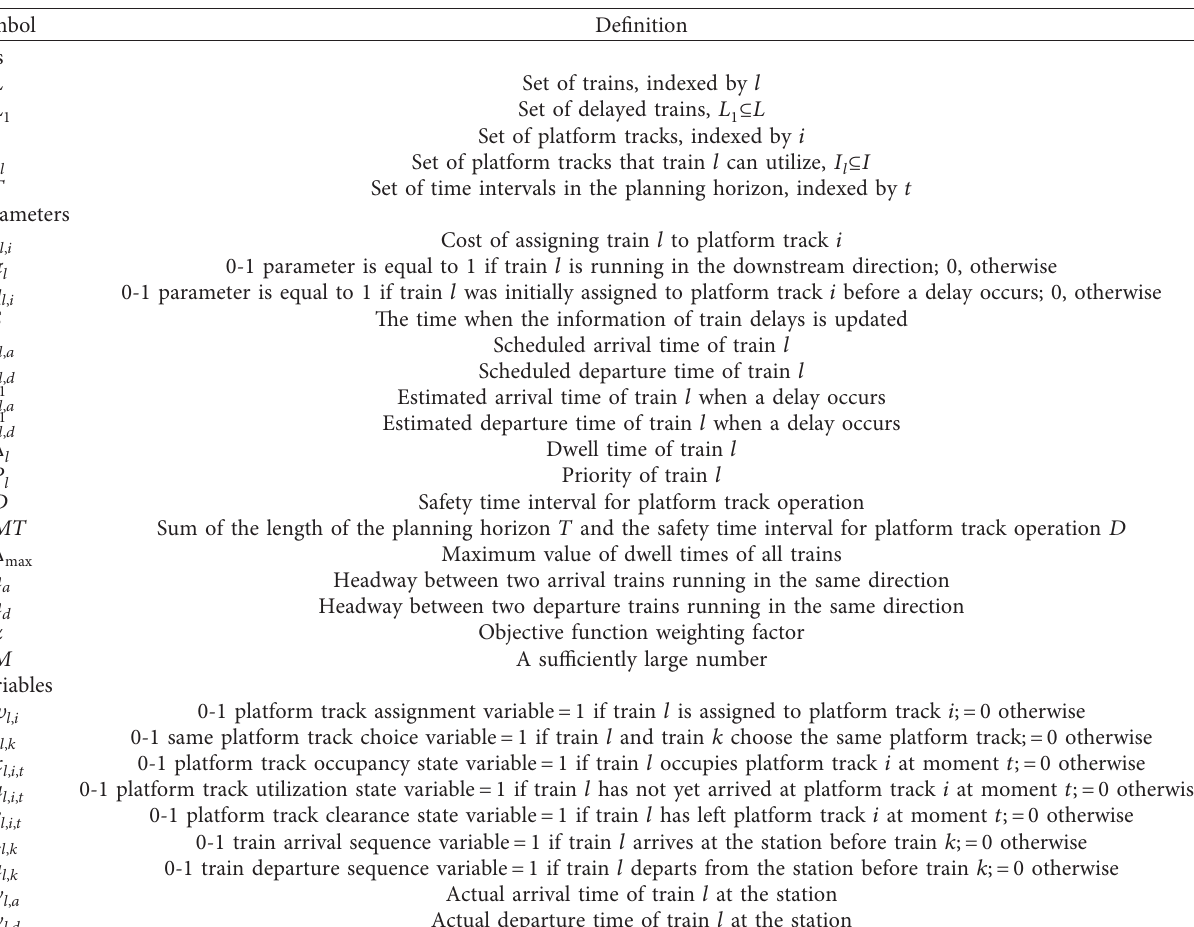
Table 2: Sets, parameters, and variables.